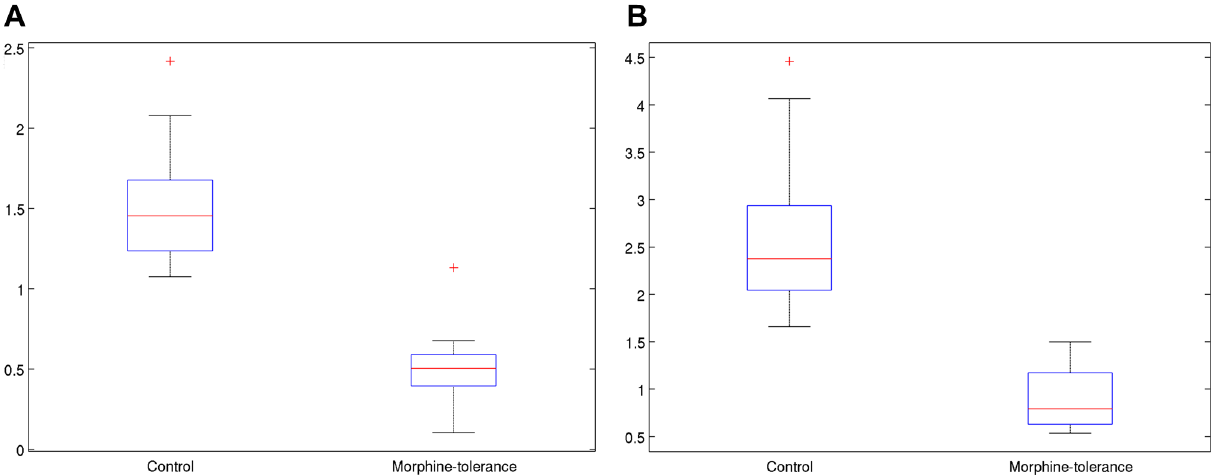
Fig 4. The statistics of M 02 (left) and M 20 (right) for the control and morphine-tolerance groups of astrocytes. The values of the morphine-tolerance group were significantly smaller than those of the control group for both M 02 and M 20